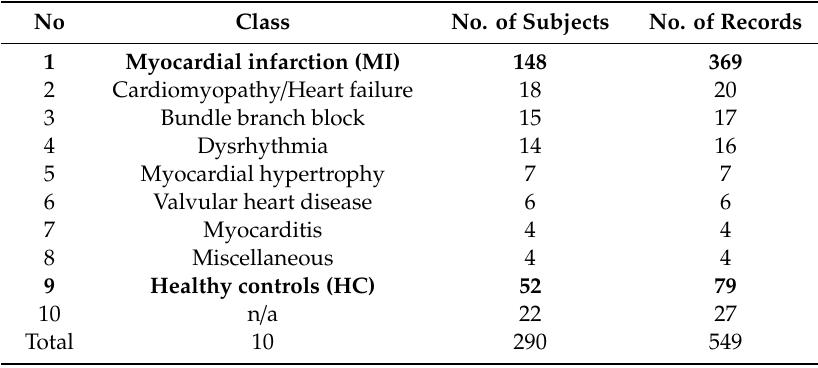
Table 1. The summary of PTB diagnostic ECG